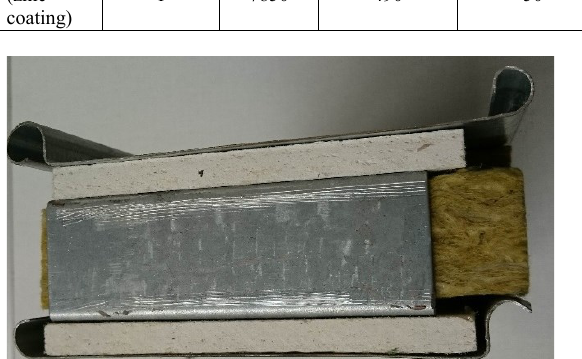
Fig. 2. Experimental results of temperature taken on outer sample